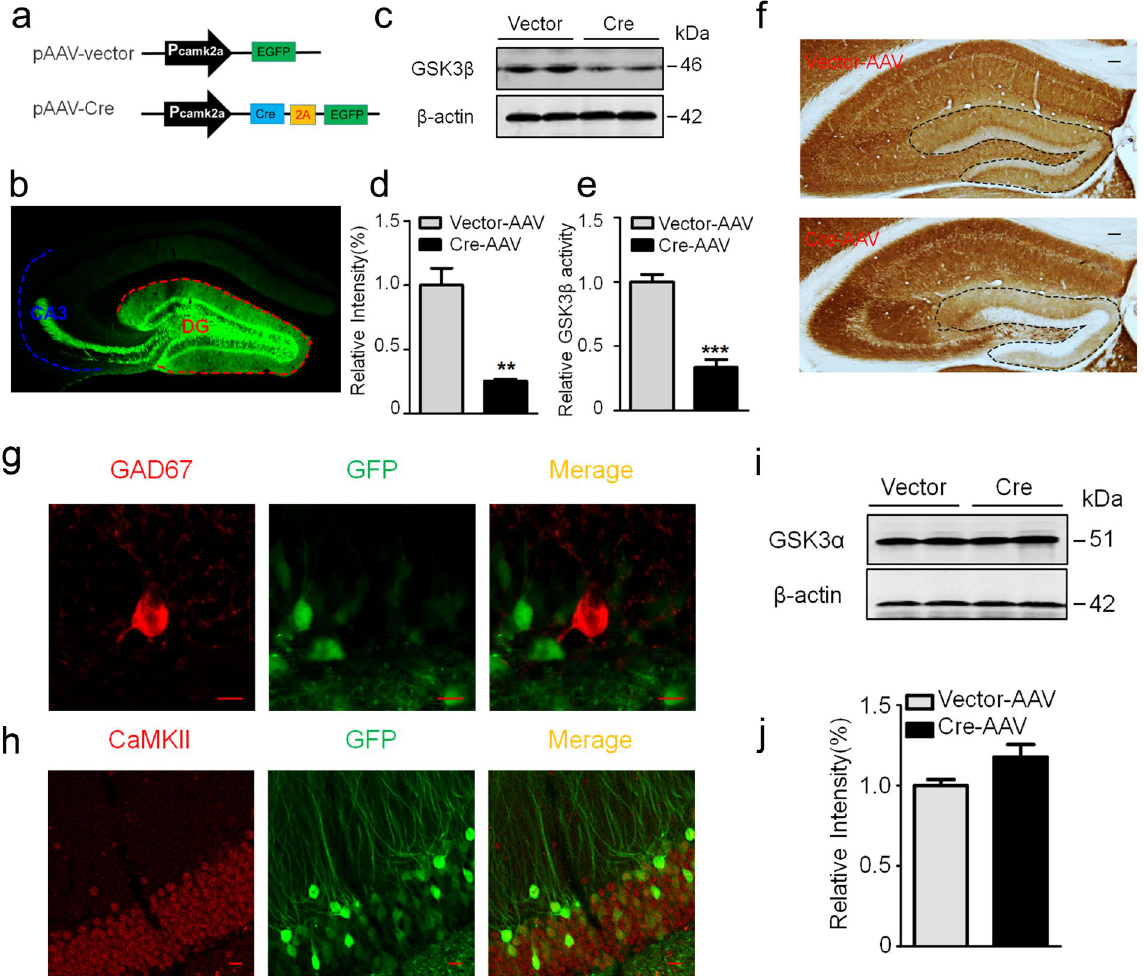
Figure 1. Expression of Cre recombinase selectively deletes GSK-3 β in DG excitatory neurons of GSK-3 β loxp mice. ( a ) Schematic representation of pAAV-CaMKII-Cre-2A-eGFP and the empty pAAV-CaMKII-eGFP vector. ( b ) A representative image showing efficient virus infection in DG and the mossy fibers. ( c,d ) Injection of Cre recombinase into hippocampal DG of GSK-3 β loxp mice for 1-m efficiently downregulated GSK-3 β protein level measured by Western blotting (n = 3 each group). ( e ) The reduced GSK-3 β activity in DG extracts after Cre recombinase injection (n = 3 each group). ( f ) Deletion of GSK-3 β in DG neurons by Cre recombinase injection measured by immunohistochemistry, scale bars, 100 μ m. ( g,h ) Specific deletion of GSK-3 β in DG excitatory neurons measured by co-immunofluorescence of GFP with CaMKII but not with GAD67 antibody, scale bars, 10 μ m. ( i , j ) Deletion of GSK-3 β did not significantly affect GSK-3 α in DG subset (n = 3 each group). Data were presented as mean ± s.e.m. unpaired t test, ** P < 0.01, *** P < 0.001 versus Vector. The absence of asterix indicates that the difference is not